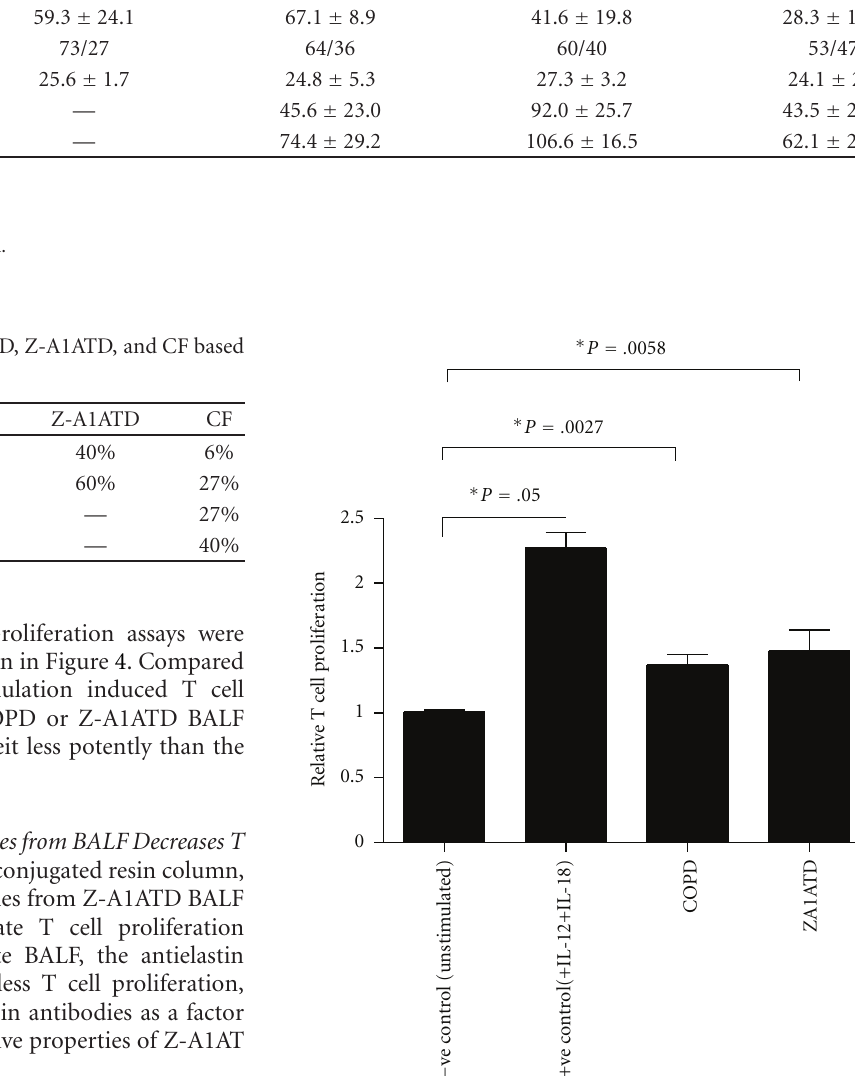
Figure 4: E ff ect of COPD and Z-A1AT BALF on T cell proliferation. T cell proliferation was measured in (1 × 10 5 ) CD3-activated Jurkat T cells left untreated, stimulated with IL-12 (10ng/mL) and IL- 18 (30ng/mL) or with Z-A1ATD BALF (500 μ L) or COPD BALF (500 μ L) for 24 hours at 37 ◦ C ( n =